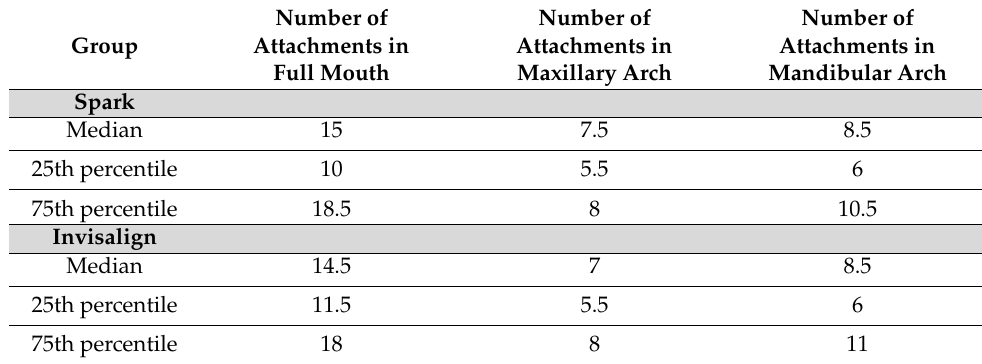
Table 1. Attachments distribution per patient in the two